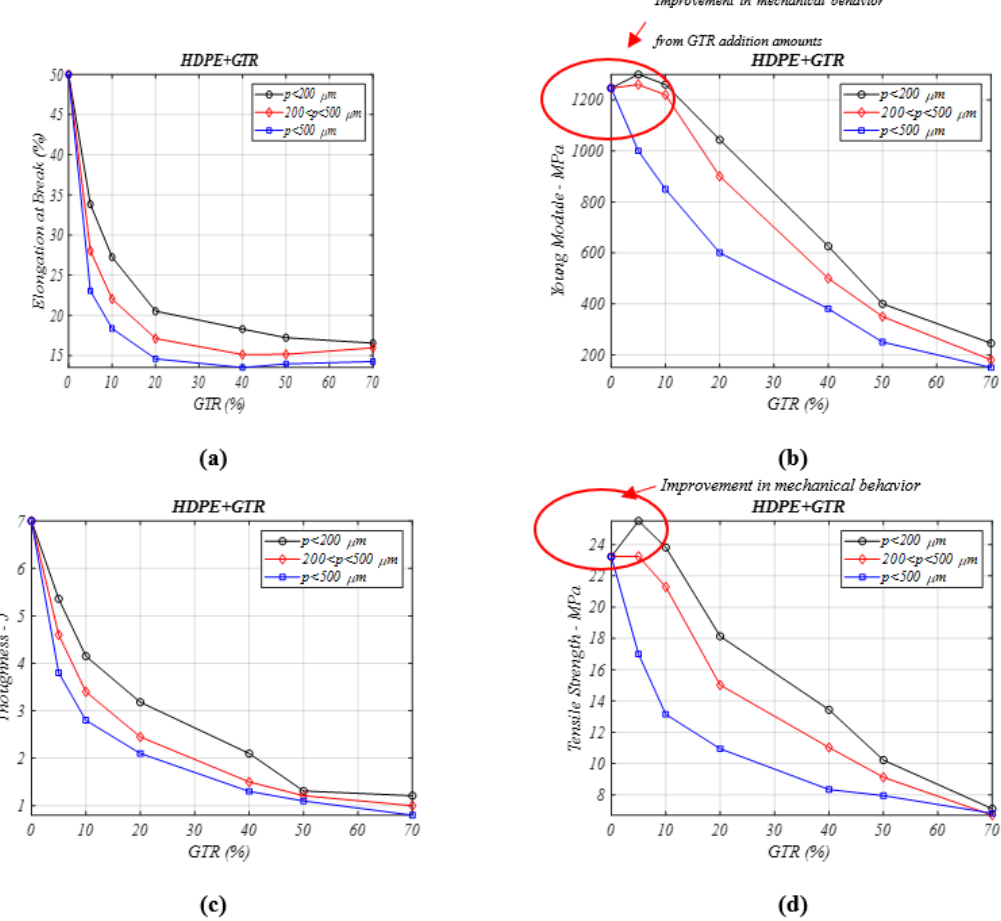
Figure 4. Mechanical properties analysis for different percentages of HDPE/GTR composites and particle diameters: ( a ) elongation at break (%), ( b ) Young ’s modulus (MPa), ( c ) toughness (J) ( d ) tensile stress (MPa). diameters: ( a ) elongation at break (%), ( b ) Young’s modulus (MPa), ( c ) toughness (J) ( d ) tensile stress (MPa).